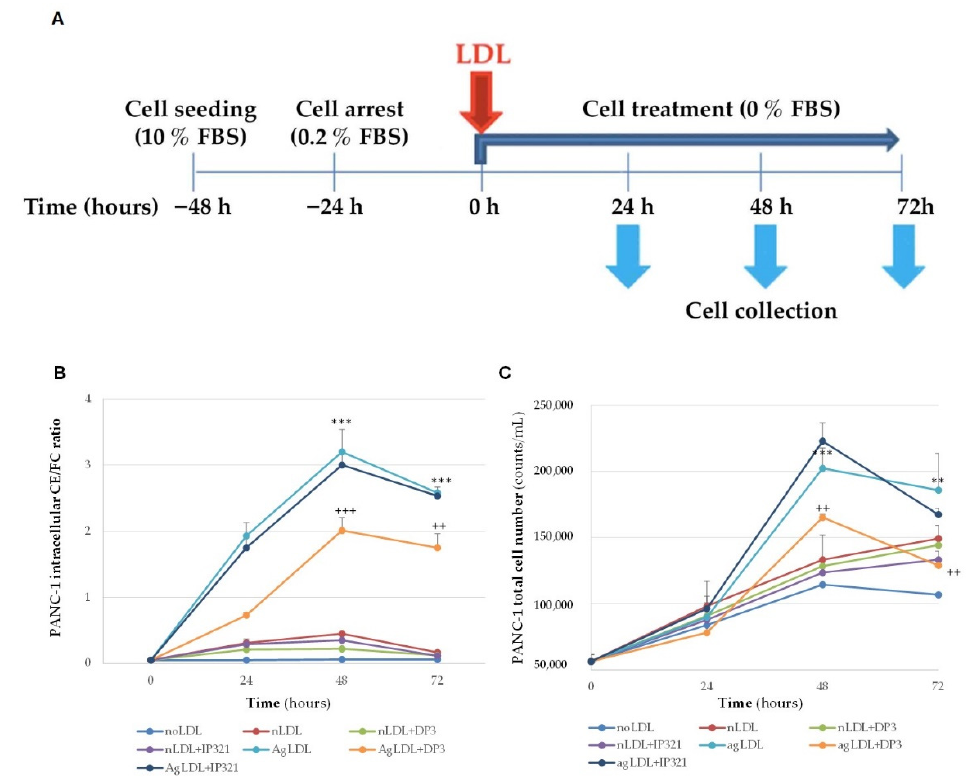
Figure 6. Time-course effects of nLDL and AgLDL on intracellular CE/FC ratio and PANC-1 total cell number. ( A ) Schematic representation of the experimental setting used to test the effect of LDL on intracellular CE/FC ratio and total cell number. Cells were untreated or treated with nLDL or AgLDL for increasing times (0, 24, 48, and 72 h) in the absence or presence of peptides (10 μ M). ( B ) Line graphs showing the intracellular ratio between CE and FC quantified bands at 0, 24, 48 and 72 h of PANC-1 exposure to AgLDLs ( C ) Line graphs showing the flow cytometry quantification of total PANC-1 cell number after their exposure to nLDLs and AgLDLs for increasing times. Data are shown as the mean ± SD of two independent experiments (three to six biological replicates). ** p < 0.01, *** p < 0.001 (noLDL vs. AgLDL); ++ p < 0.01, +++ p < 0.001 (AgLDL + DP3 vs. AgLDL + IP321). Statistical significance was determined by Student’s t test. LDL, low-density lipoprotein; nLDL, na- tive LDLs; AgLDLs, aggregated LDLs, CE cholesteryl esters; FC free cholesterol. Raw data can be found in File S1 and flow cytometry dot plots can be found in Figure S11.